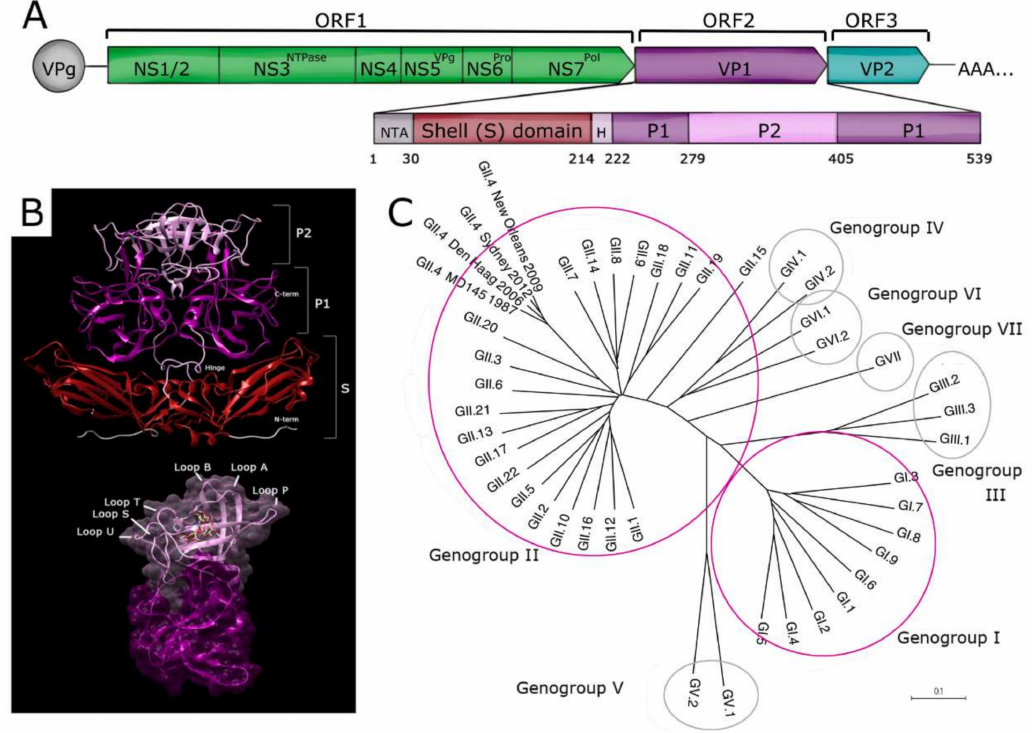
Figure 1. ( A ) Organization of the human norovirus genome. ORF1 (green) encodes the nonstructural proteins, ORF2 (purple) encodes the major structural capsid protein, VP1, and ORF3 (blue), encodes the minor structural protein, VP2. Amino acids are numbered according to a representative GI.1 genome (GenBank: KF429765.1). The VP1 protein is divided into two major domains: Shell (S) and Protruding (P) [17]. The S domain is immediately preceded by a short N-terminal arm (NTA), and the S and P domains are connected by a flexible hinge region (H). The P domain is further subdivided into P1 and P2. ( B ) Structural modeling of the capsid VP1 dimer. VP1 dimerizes from two protein chains (A and B), with the S domain constructing the inner part of the capsid that surrounds the RNA genome. P1 domains fold into each other, allowing P2 to become the most exposed portion of the dimer. Loops are labeled according to GI.1 nomenclature [18]. ChimeraX was used to model loops and HBGA binding (GI.1 PDB 2ZL6). ( C ) Genetic diversity of norovirus VP1. Representative VP1 sequences from each genotype were aligned using MEGA. Genotypes cluster into Genogroups GI through GVII. The majority of human noroviruses belong to Genogroups GI and